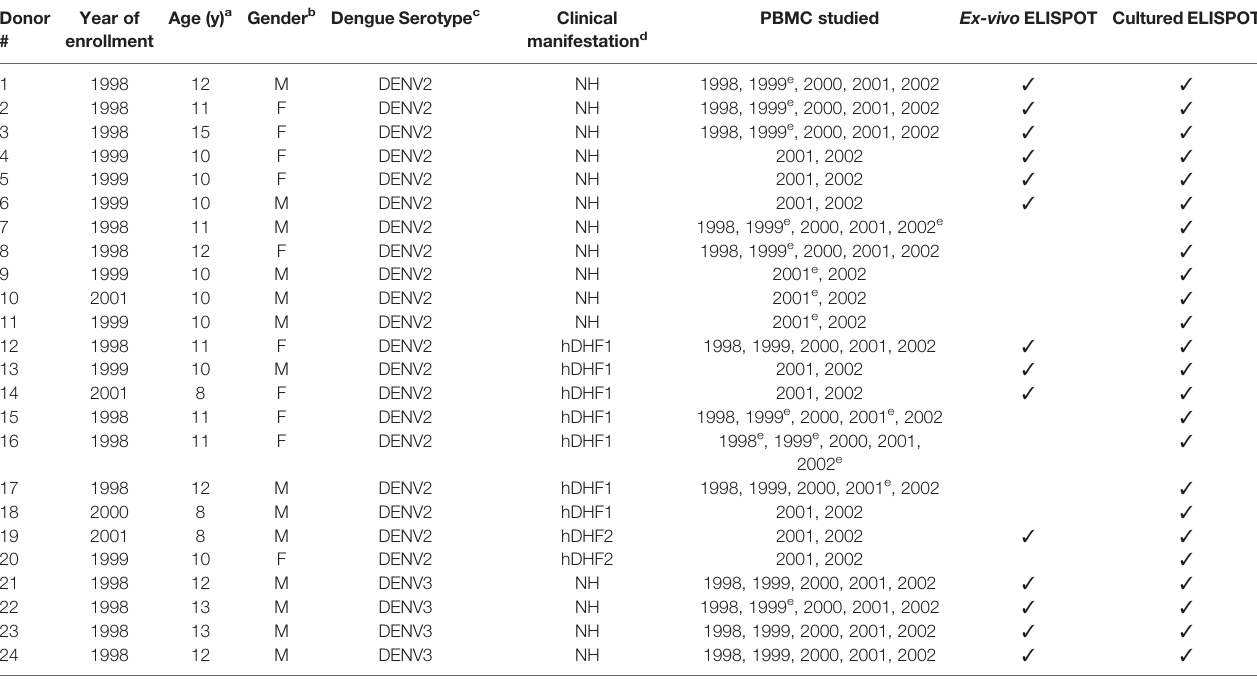
TABLE 1 | Characteristics of the study